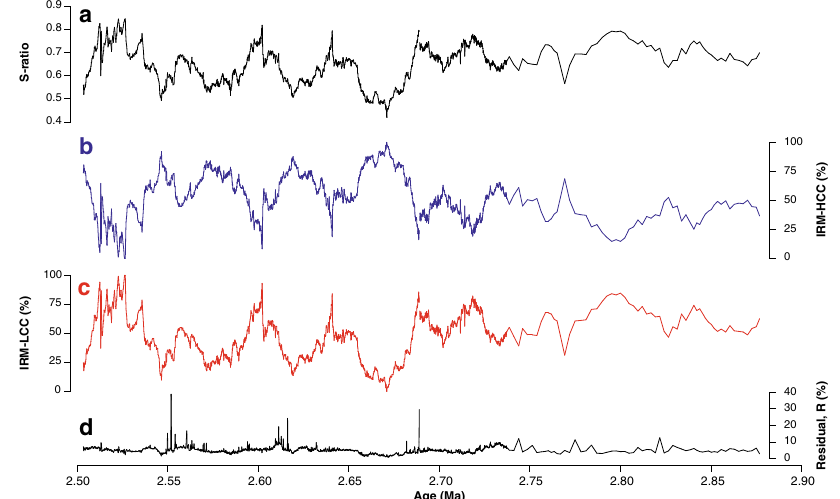
Fig. 5 Decomposition of IRM gradient curves to the HCC and LCC. a S-ratio. b Fraction of HCC. c Fraction of LCC. d Residual: integral of absolute values of residuals normalized by the IRM intensity at 1 T.